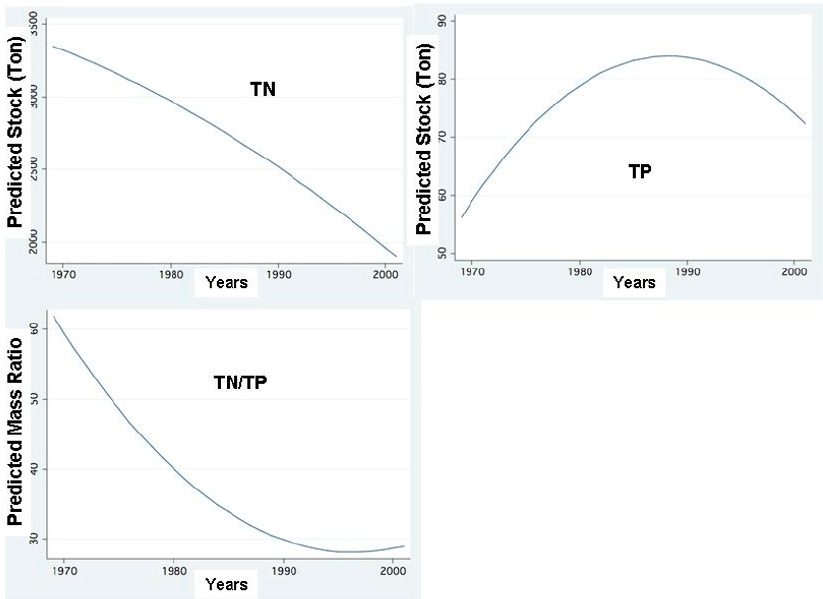
Figure 15. FP Regressions between annual averages of Standing Stocks (Ton) in the entire lake of Total Nitrogen (TN), Total Phosphorus (TP), and TN/TP mass ratio and Years. As part of climate change indication, air and water temperature increases since the early 1980s are shown in Figures 16 and 17.